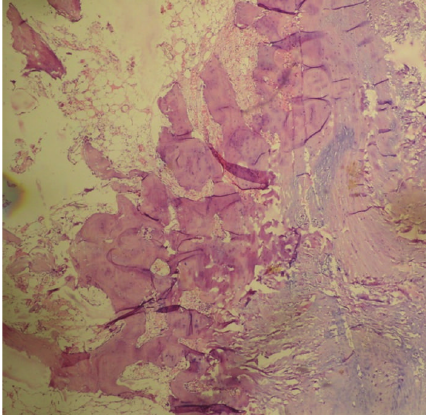
Figure 6: Histopathology: This figure shows bone marrow, bone and cartilage with fibrofatty tissue at the periphery.